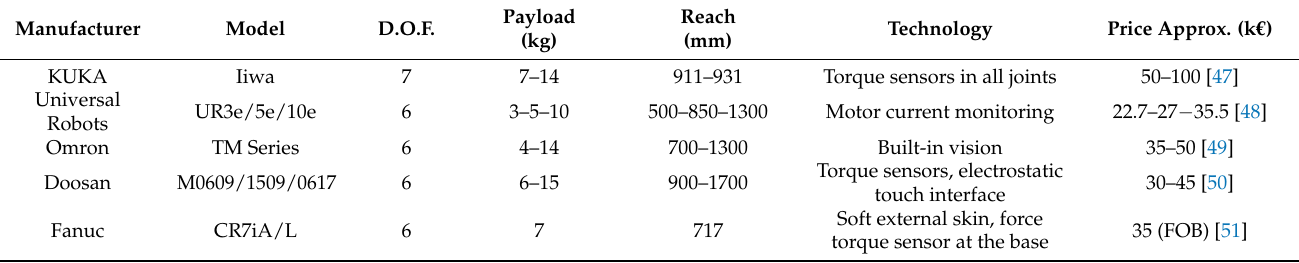
Table 1. Selected specifications and price some cobots from leading manufacturers.